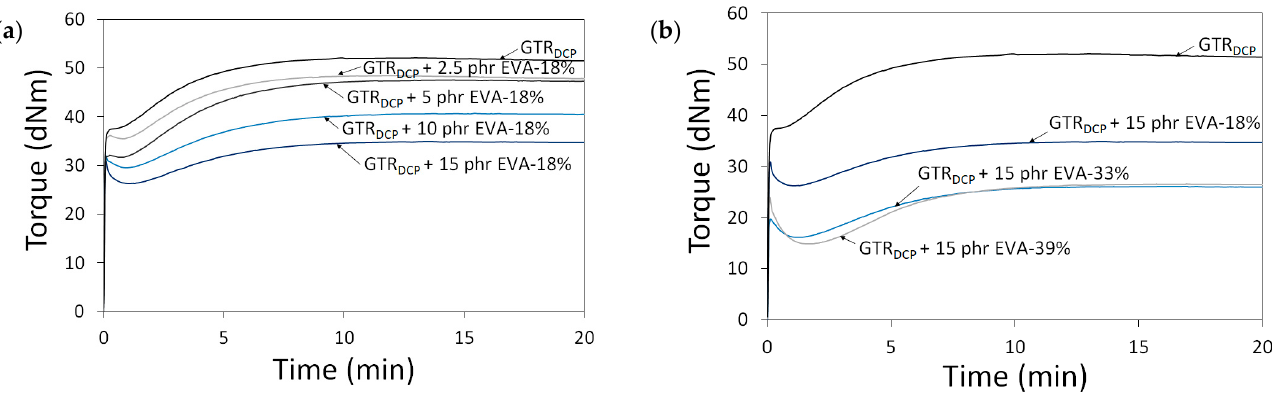
Figure 2. Curing curves for modified GTR determined at 170 °C as a function of: EVA content (0–15 phr) ( a ) and EVA grade (VA content: 18–39%) ( b ).